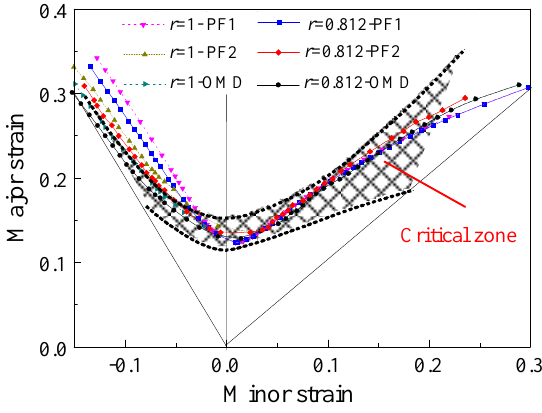
Figure 13. Effect of thickness inhomogeneity on FLCs.